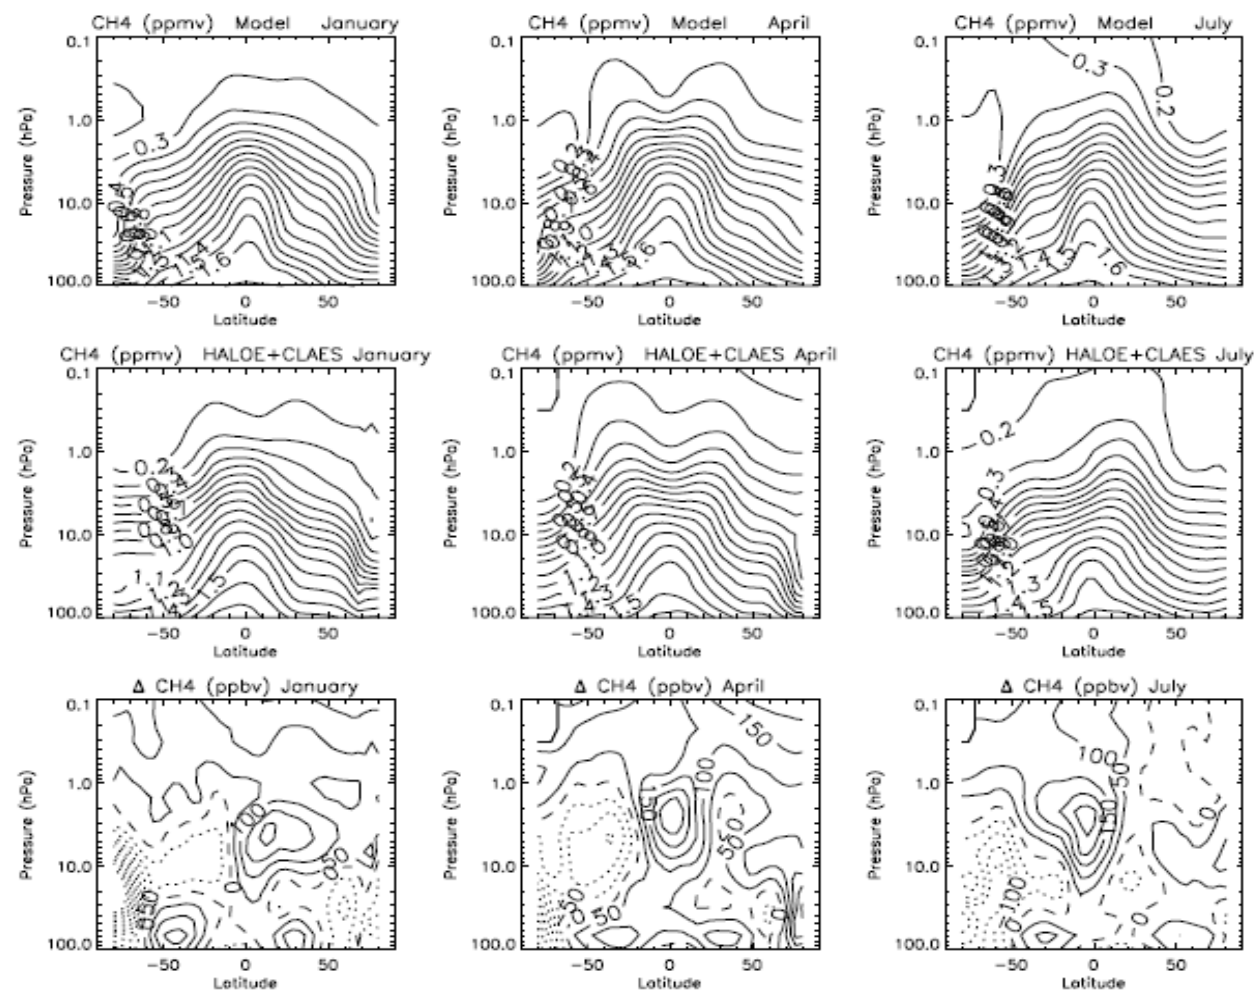
Fig. 6. January, April and July zonal mean distributions of CH 4 mixing ratios (ppmv) simulated by the model for the period 1991–1997 Figure 6: January, April and July zonal mean distributions of CH (top), observed by HALOE and CLAES (middle) and their differences (ppmv) simulated by the model for the period 1991-1997 (top), observed by HALOE 4 and CLAES (middle) and their differences (bottom). 5